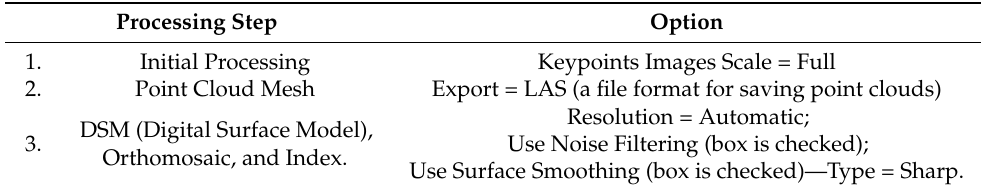
Table 3. Processing options set in Pix4Dmapper during 3D canopy model